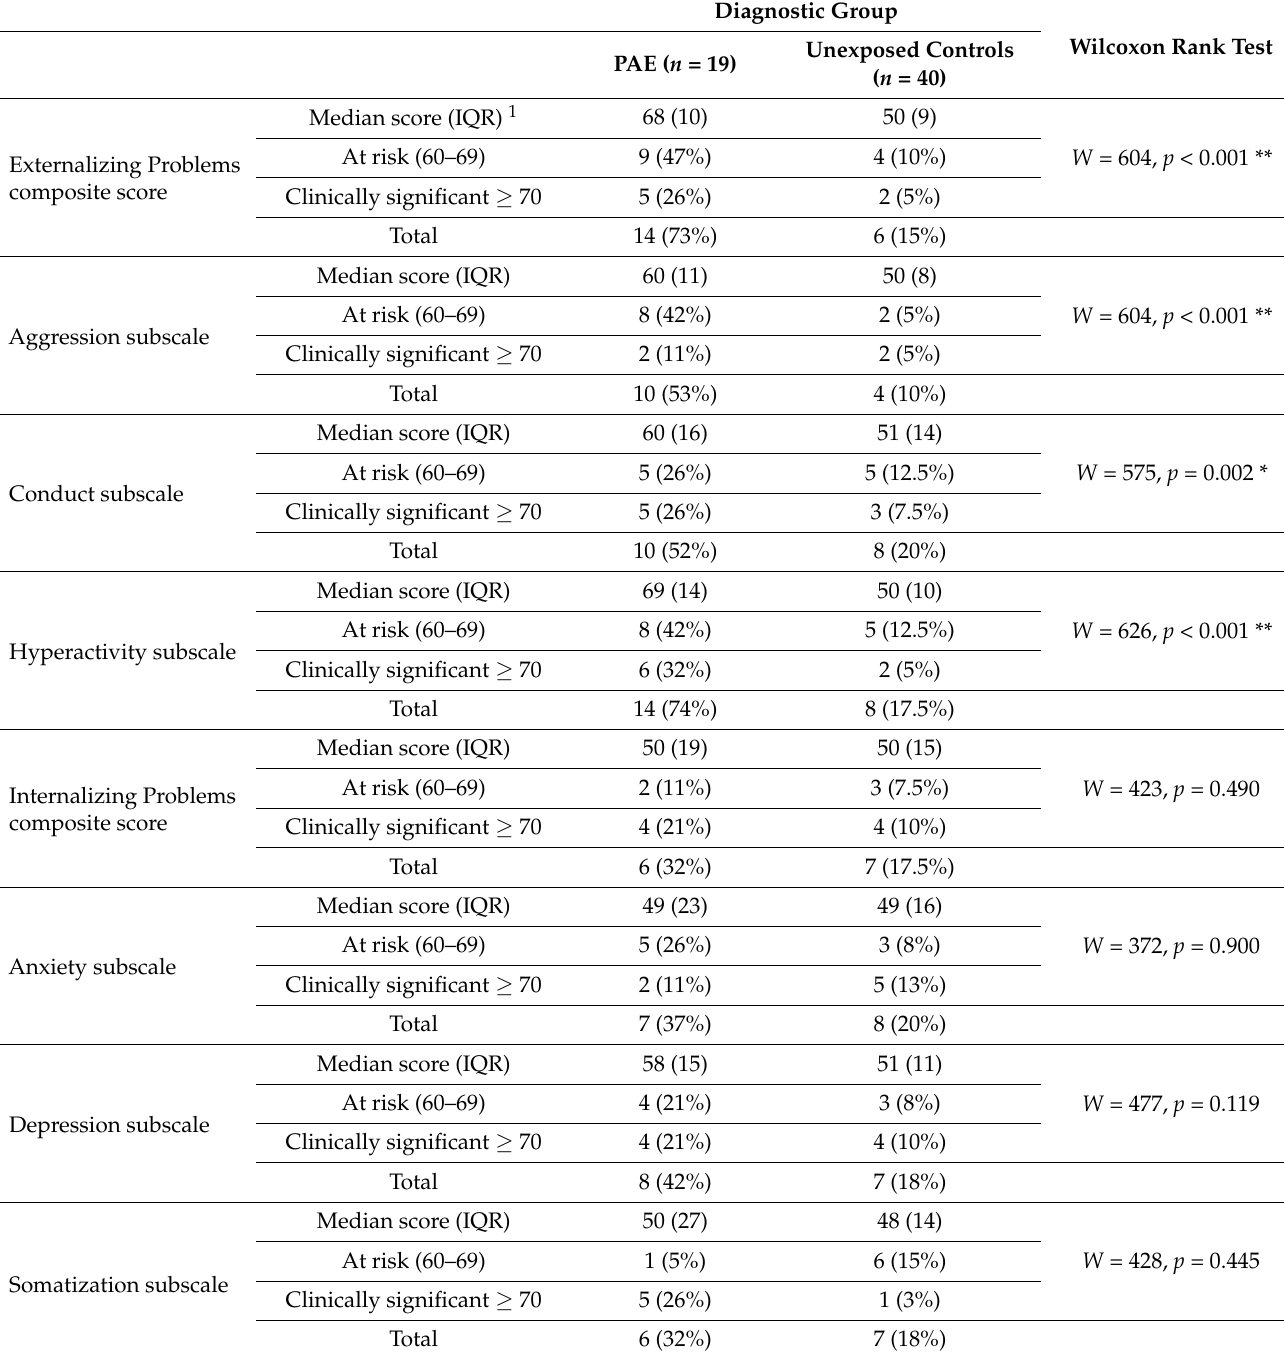
Table 4. Comparison of Externalizing and Internalizing BASC-2-PRS T scores by diagnostic